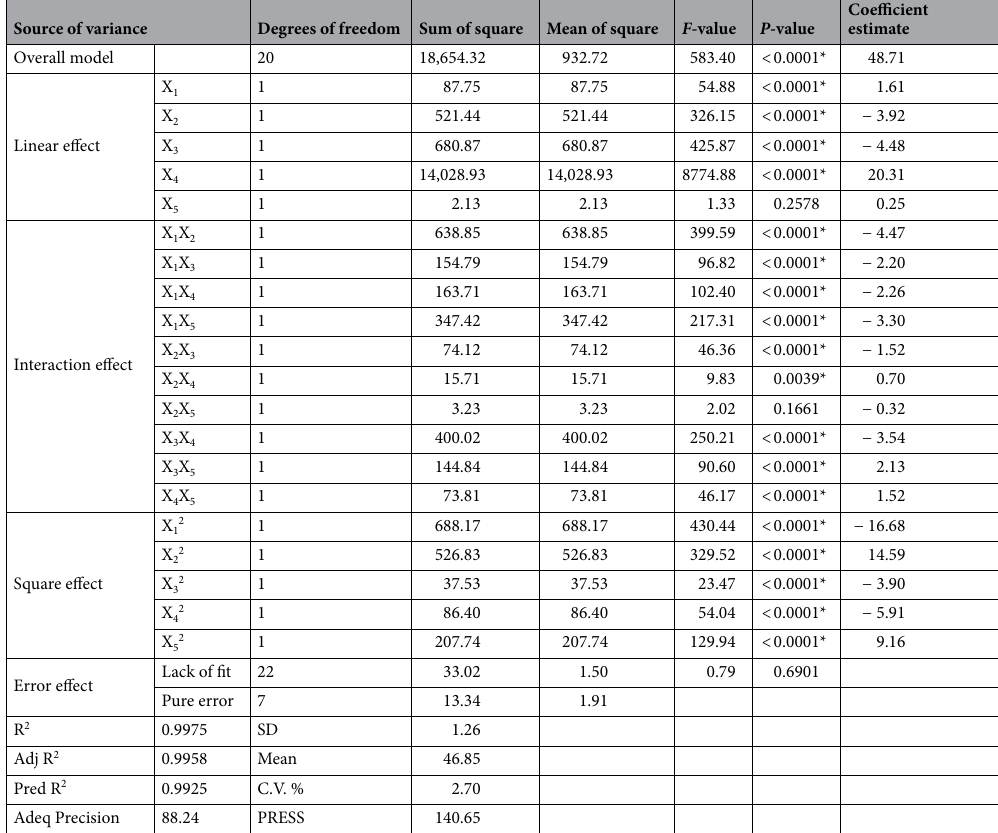
Table 3. Analysis of variance for simultaneous biosorption of cobalt by E. intestinalis achieved by the FCCCD. *Significant values, F , Fishers’s function; P , level of significance; C.V, coefficient of variation.